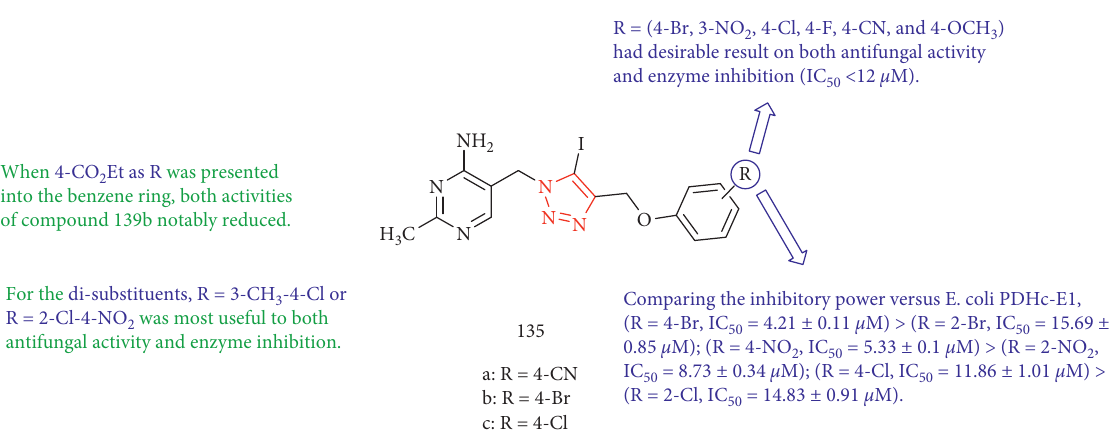
Figure 69: Chemical structure of the new 5-iodo-1,4-disubstituted-1,2,3-triazole